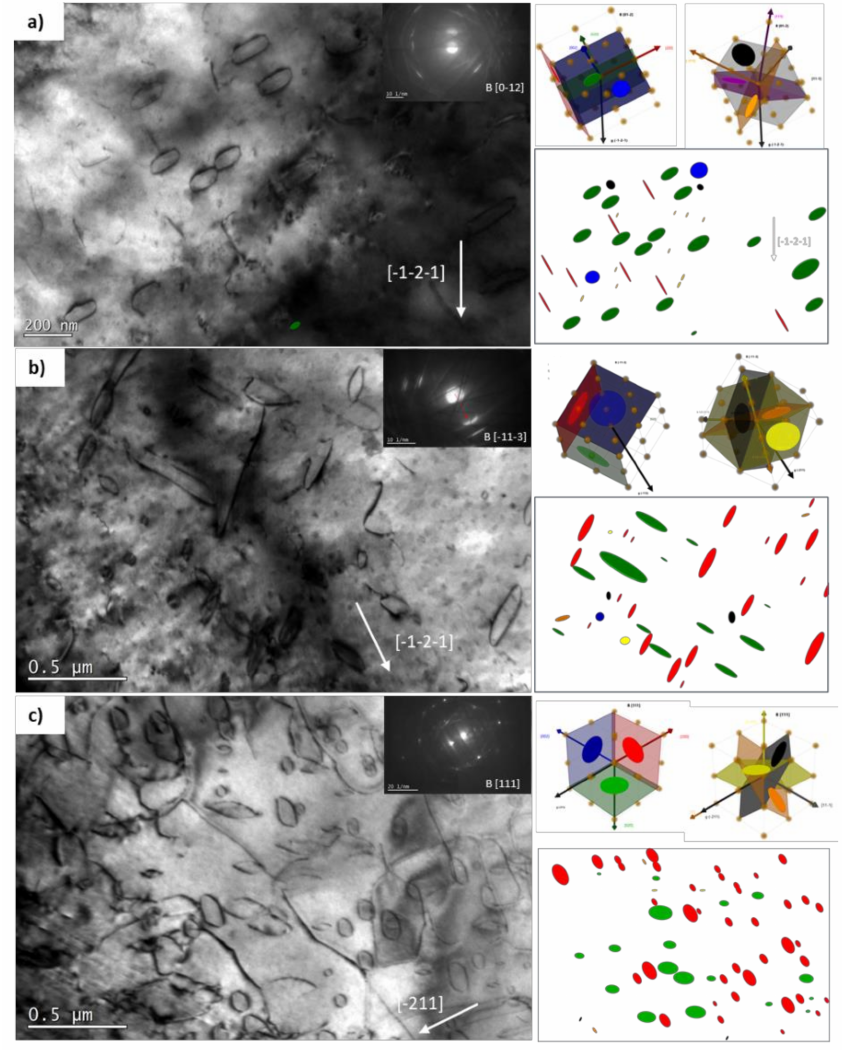
Figure 19. TEM micrographs of pure EFDA iron irradiated with Fe ions at 20 MeV at 300 ◦ C up to 8.5 × 10 15 ions/cm 2 under ( a ) [012] with g [121]; ( b ) [113] with g [121]; and ( c ) [111] with g [211], showing the results for every